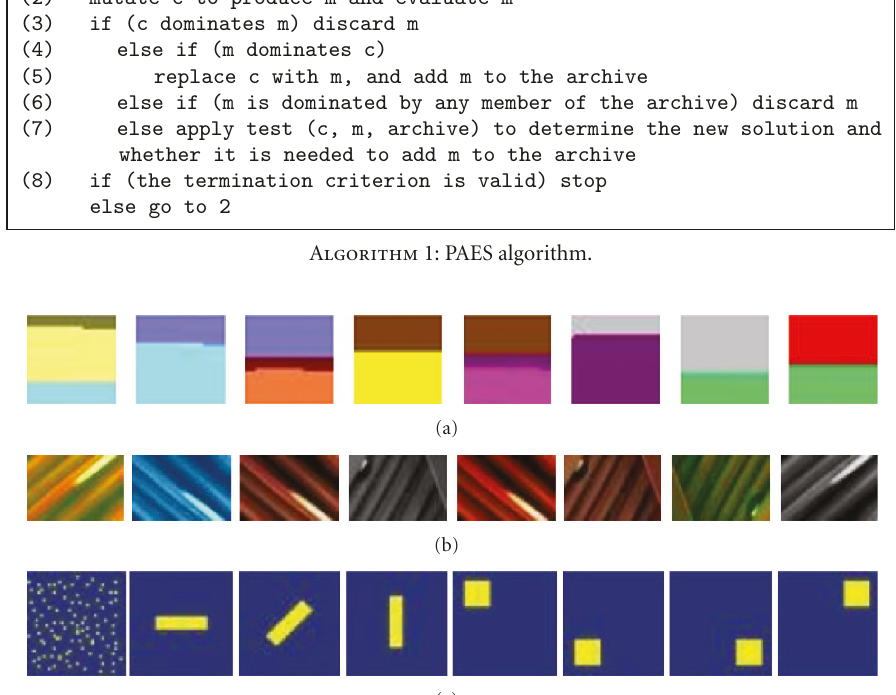
Figure 6: Three groups of 8 image blocks which well-defined low-level